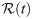
Reproduction function in Lombardia.
ℛ(t) predicted until 24/06/2020 after the calibration of fSEIRDe (red continuous line) and fSEIDRr (blue dash-dotted line) on the data in the period [24/02-27/03].